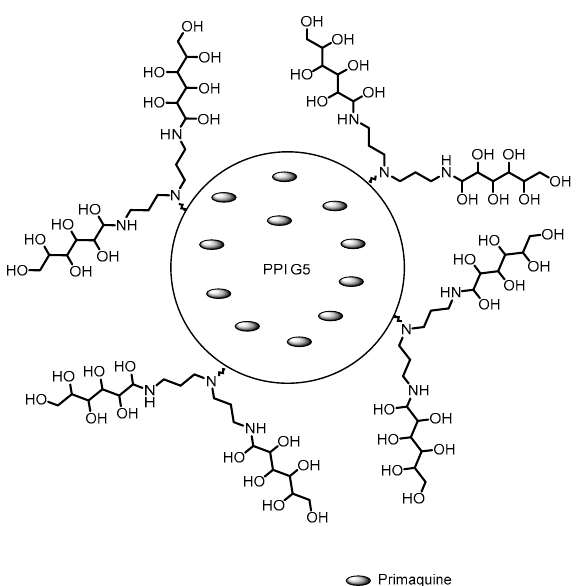
Figure 9. PPI G5 dendrimer conjugated with galactose and encapsulated with primaquine [66].